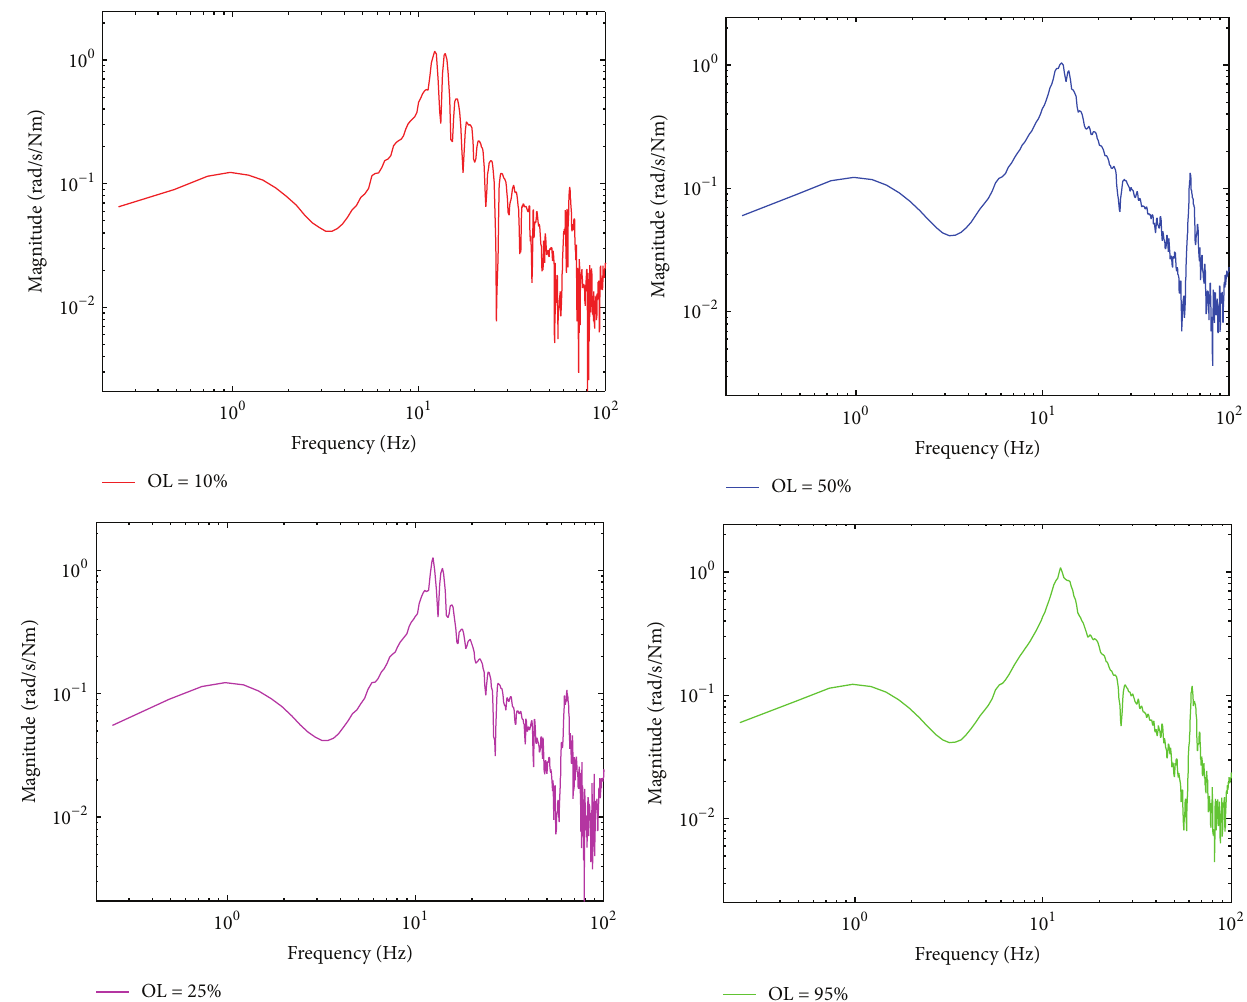
̇𝜃 /𝑇 5 5 with Hamming window (windows length 2.5 s).